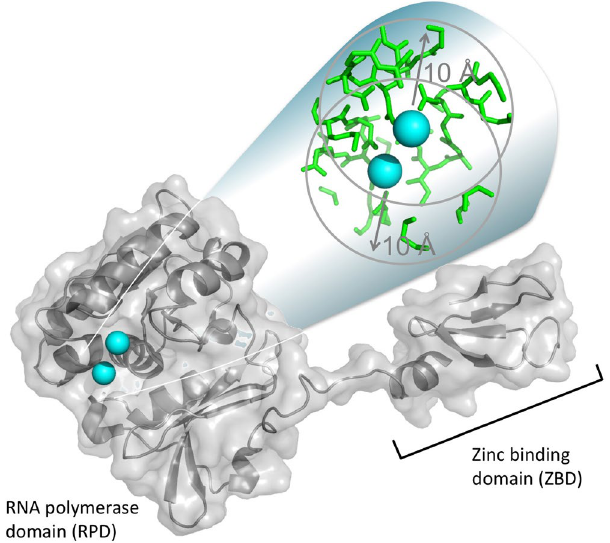
Figure 1. Crystal structure of the phage T7 DNA primase domain of the gene 4 product (PDB entry 1 nui). The two-metal cofactor binding site is emphasized. The residues located within a radius of 10 Å of Mg(II) are colored green. The figure was created using PyMOL